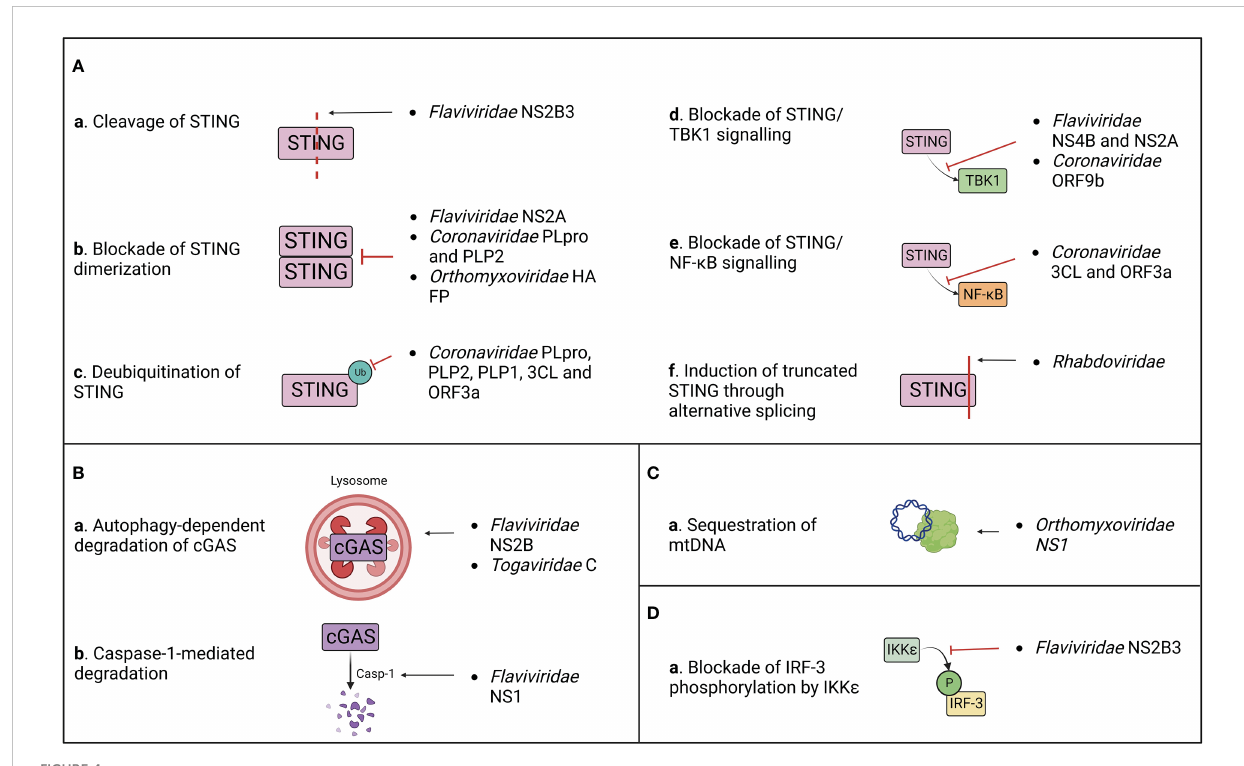
FIGURE 4 Summary of the known mechanisms of cGAS/STING antagonism by RNA viruses as described in (Table 1). Viral evasion strategies targeting STING (A) , cGAS (B) , mitochondrial DNA (C) or STING-dependent downstream signaling (D)